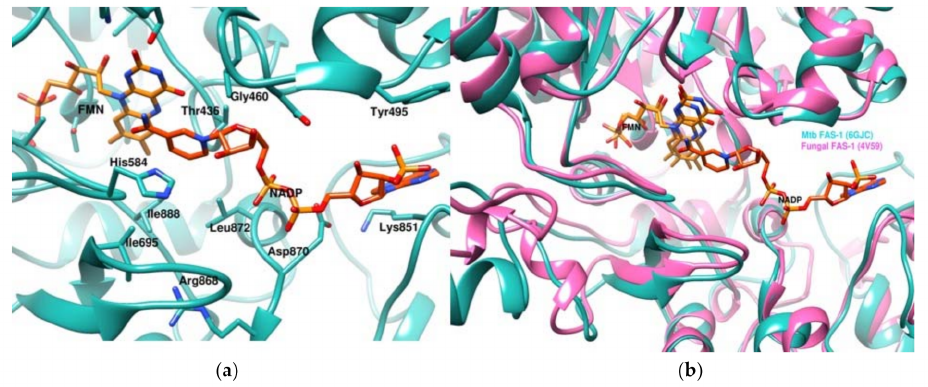
Figure 1. ( a ) Mtb FAS-I shown in cyan color with bound FMN and docked NADP ( b ) The enoyl re- ductase domain of Mtb FAS-I (cyan color, PDB:6GJC) superimposed onto Thermomyces lanuginosus FAS-I (pink color, PDB:4V59). Table 1. The residue comparison for the NADPH binding site of enoyl reductase between fungal and Mtb